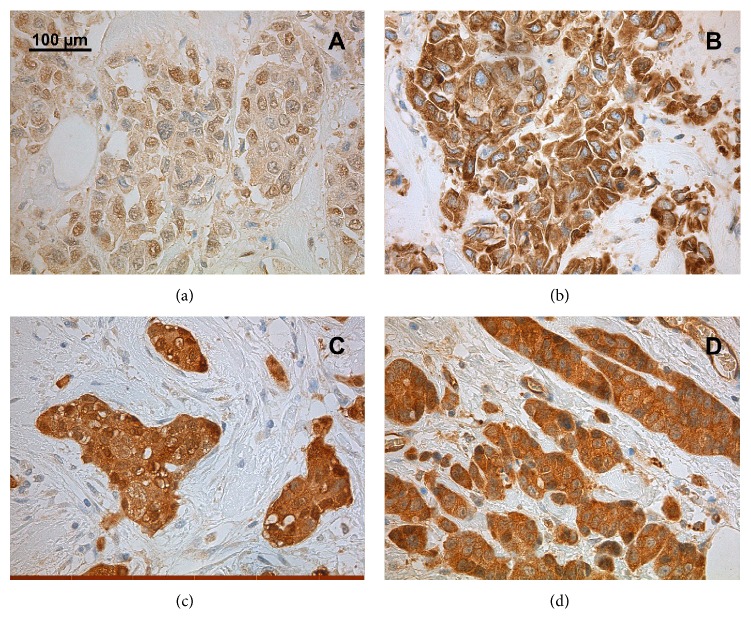
Immunohistochemical detection of protein levels of Keap1 (a), Nrf2 (b), Trx (c), and Prx I (d) in postoperative samples of NACT-treated patients. The figures represent samples with weakly positive (a), moderately/strongly positive (b), and strongly positive (c, d) cytoplasmic staining. None of the tumor samples were totally negative, but negative staining can be seen in connective tissue (c, d). Nuclear staining is negative in figures (b) and (d) and partly moderately positive in (a) and (c).